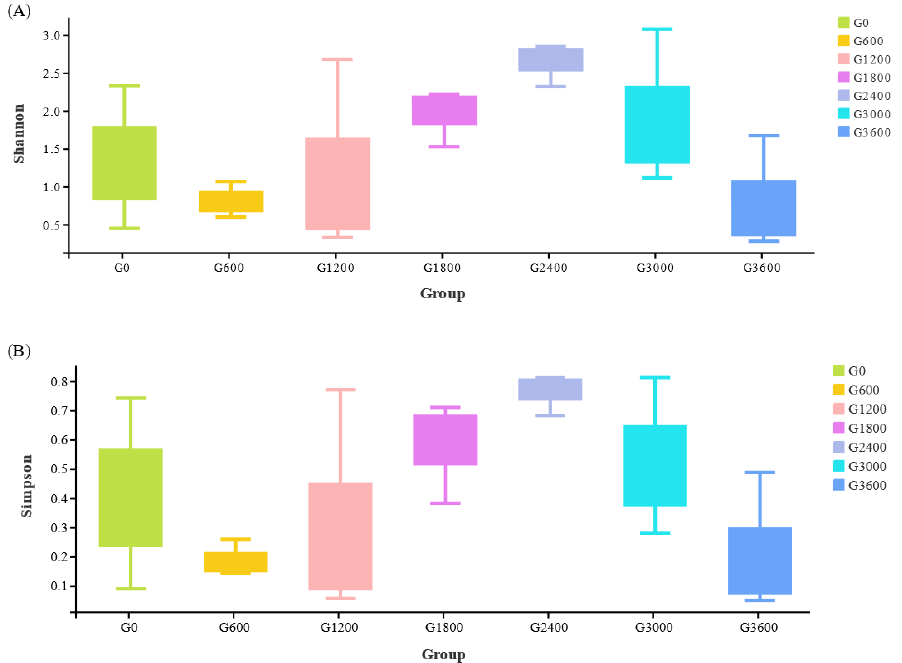
Figure 6 Figure 6. Effects of dietary GML levels on ( A ) Shannon and ( B ) Simpson indices for juvenile grouper. Figure 6. Effects of dietary GML levels on Shannon and Simpson indices for juvenile grouper.